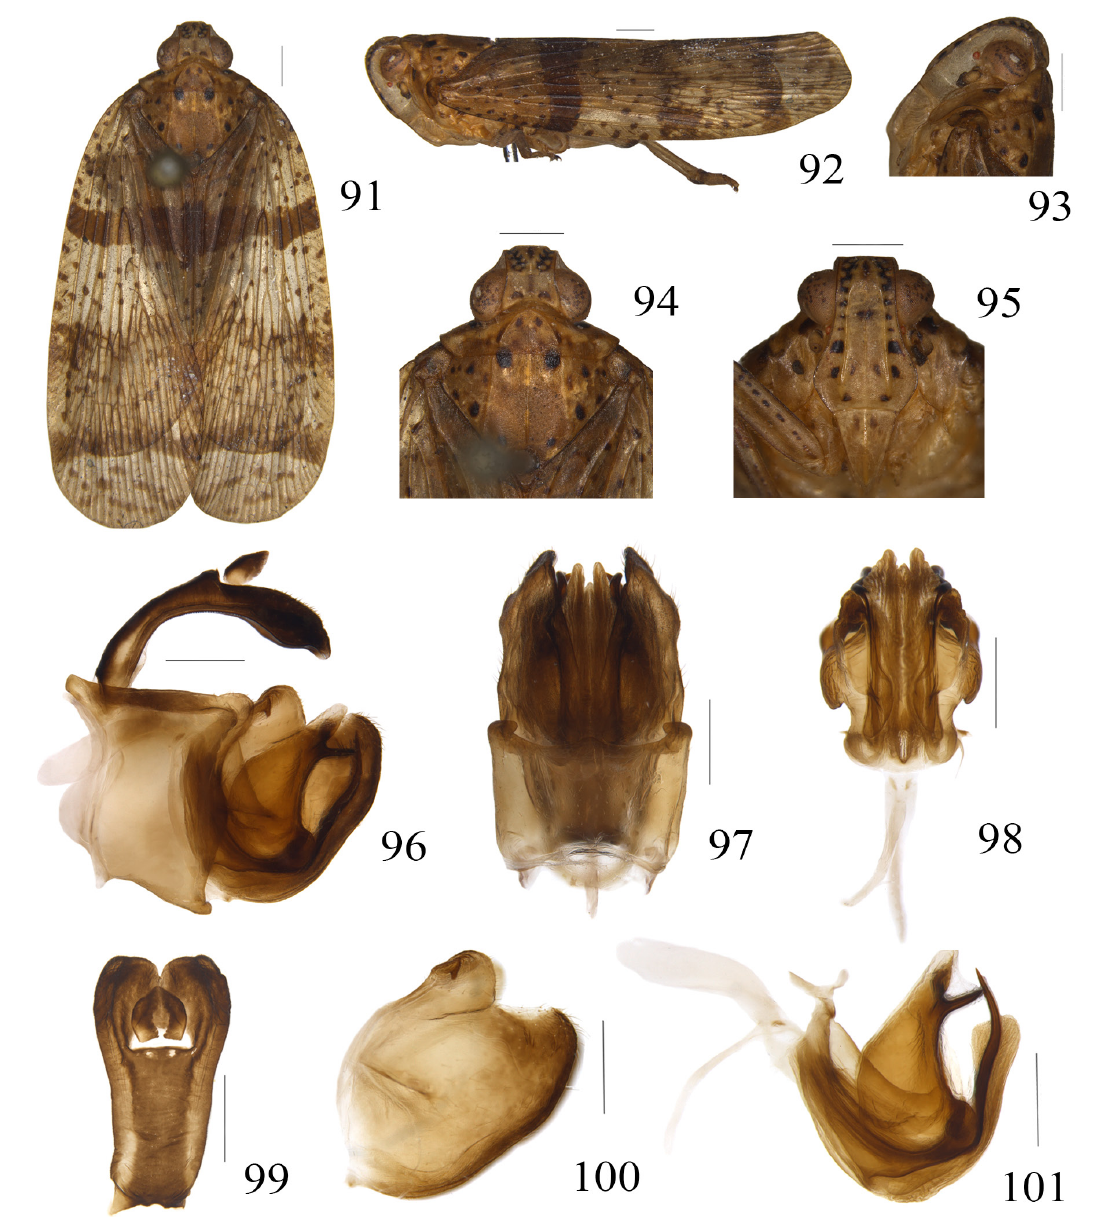
Figs 91–101. Acothrura fucizona Wang, Chou & Yuan, 2000, paratype, ♂. 91 . Habitus, dorsal view. 92 . Habitus, lateral view. 93 . Head, lateral view. 94 . Head and thorax, dorsal view. 95 . Frons and clypeus. 96 . Male terminalia, lateral view. 97 . Male terminalia, ventral view. 98 . Phallic complex, ventral view. 99 . Anal tube, dorsal view. 100 . Gonostylus, lateral view. 101 . Phallic complex and tectiform structure, lateral view. Scale bars: 91–95 = 1 mm; 96–101 = 0.5